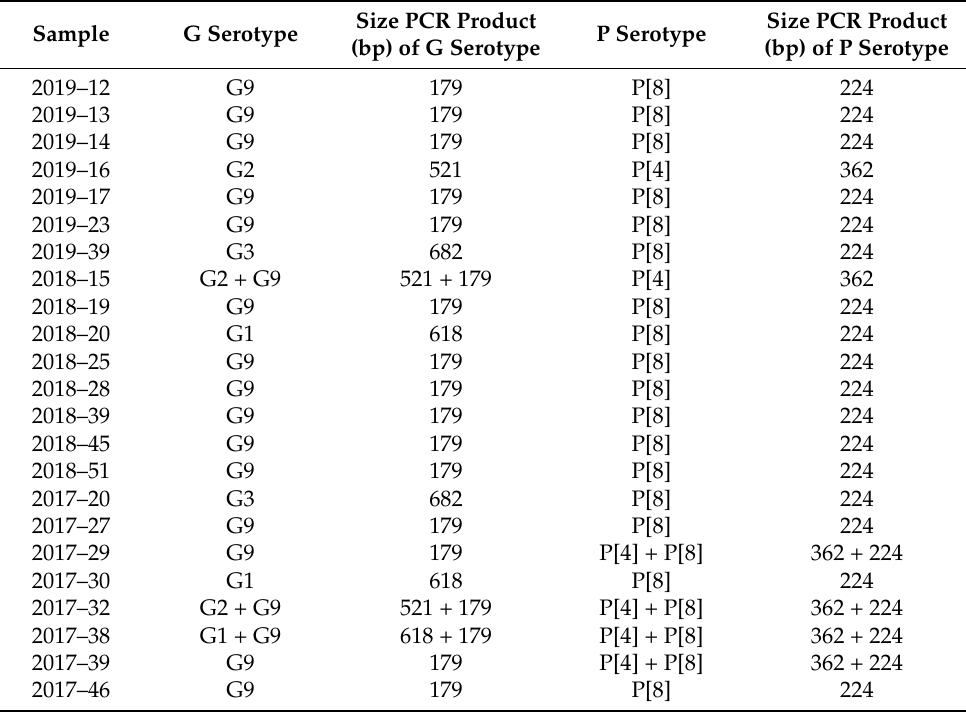
Table 5. Electrophoresis results of G/P typing of rotavirus from 2017 to 2019.